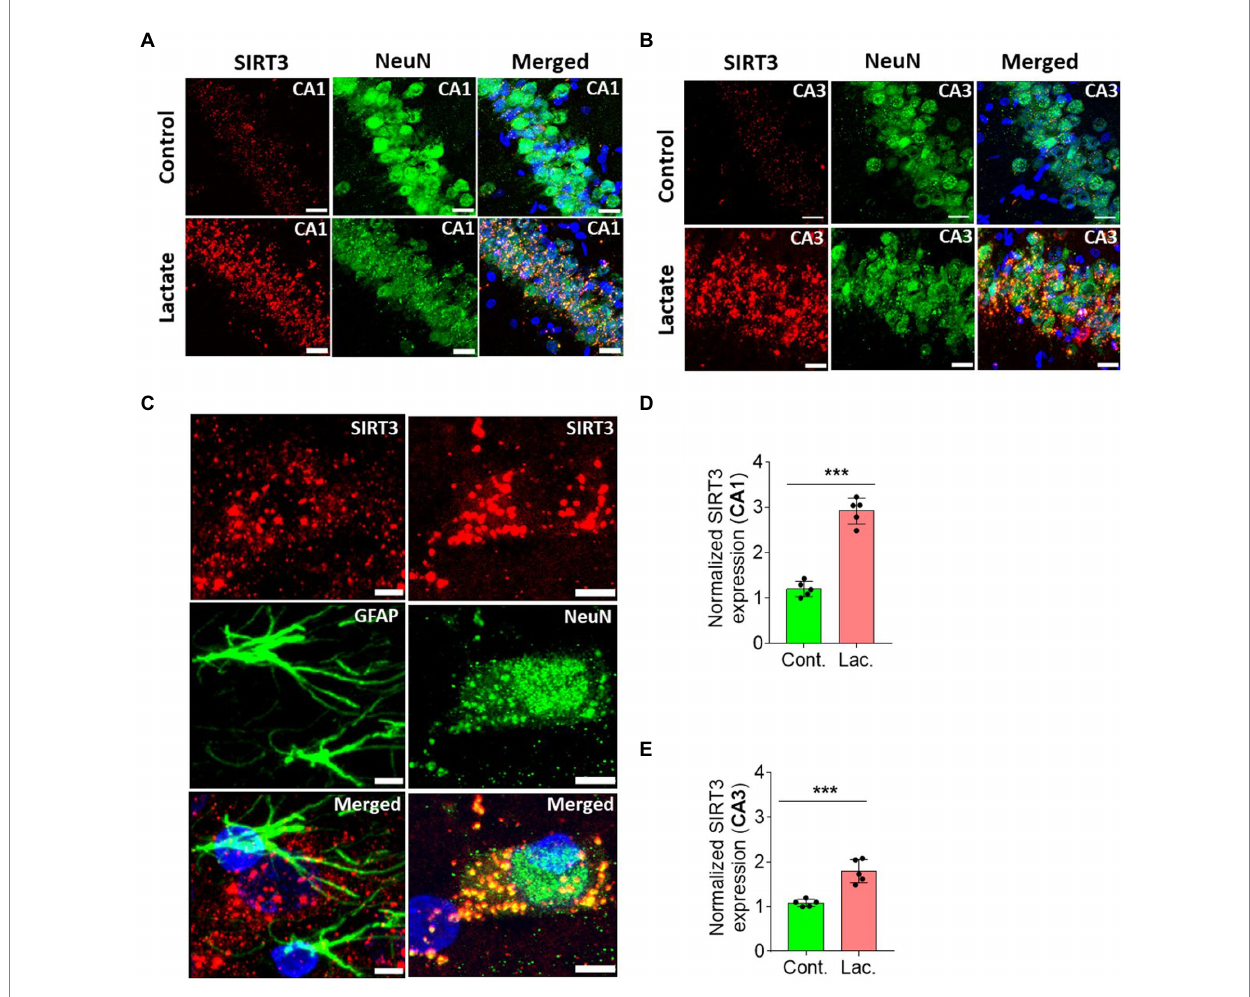
FIGURE 2 L-lactate causes increased SIRT3 expression in neurons of HPC. (A,B) Representative confocal micrograph of SIRT3 (red) co-labelled with NeuN (green) in the CA1 (A) and CA3 (B) areas of HPC of control and lactate groups. L-lactate infusion increased SIRT3 expression in both areas. Scale bars: 20 μ m. (C) Representative confocal micrograph of SIRT3 (red) co-labelled with GFAP (green) or NeuN (green) in the HPC of lactate group. Scale bars: 5 μ m. (D,E) Fluorescence intensity of SIRT3 stained sections in the CA1 (D) and CA3 (E) areas of HPC of lactate group was assessed and normalized to control group of rats. Data is shown as mean ± SD ( n = 5 rats per group). p *** < 0.001, unpaired Student’s t